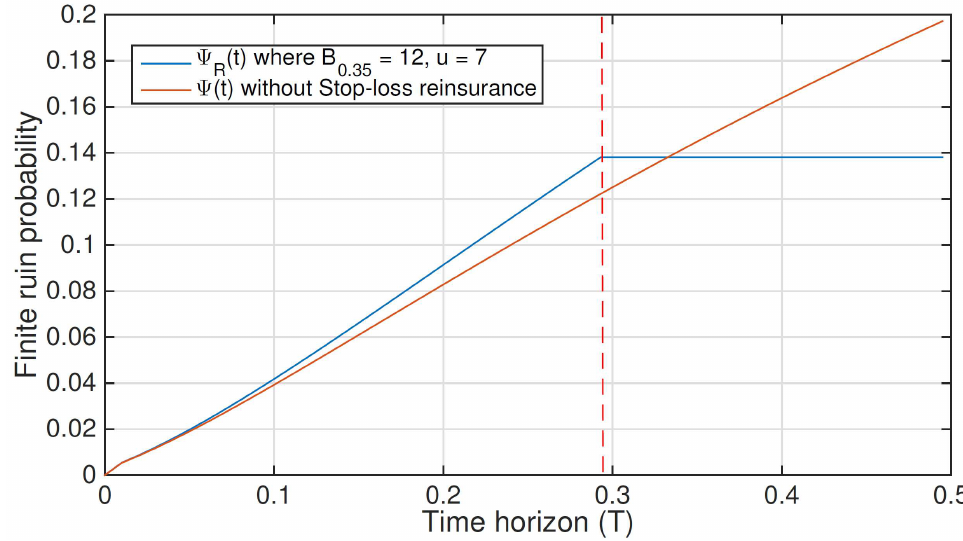
Figure 6. Finite-time ruin probability with and without stop-loss reinsurance.